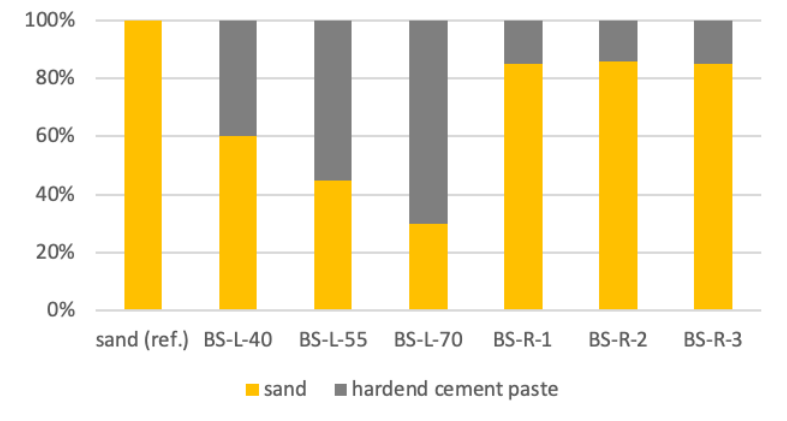
Figure 3. Samples of crushed sand and their content of hardened cement paste.